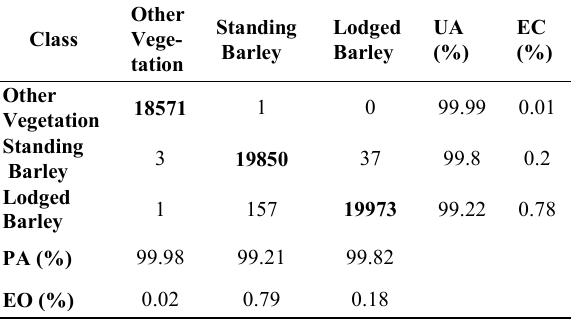
Table 4. Random Forests confusion matrix for the validation dataset with User's and Producer's class Accuracies and Errors of Omission and Commission. The bold figures indicate correctly classified pixels for each class.